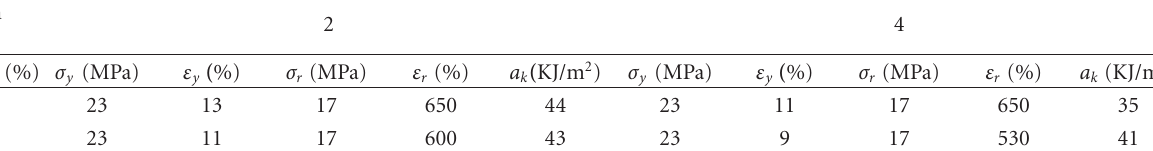
Table 2: Mechanical characteristics of PP/kaolin composites as a function of kaolin and silane concentrations.